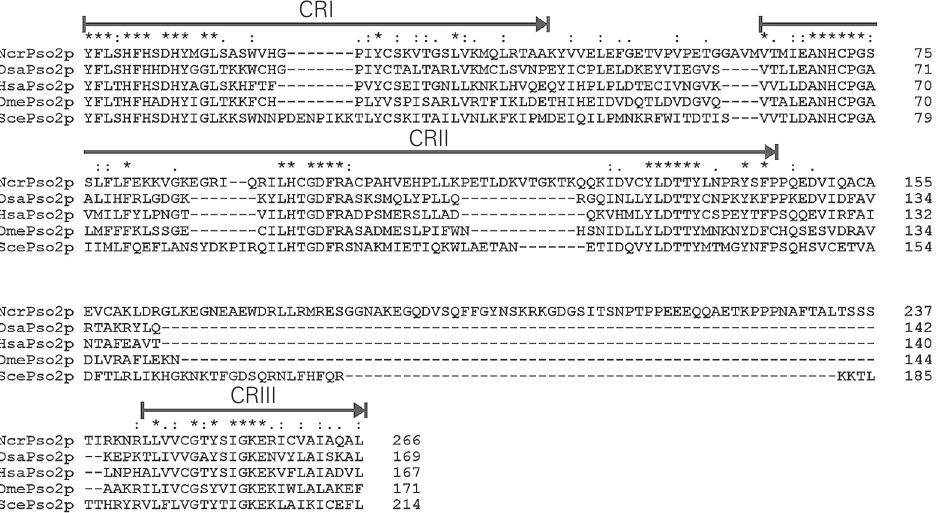
Figure 3. Multiple alignment of Pso2p conserved region sequences (CRI to CRIII) from yeast ( Saccharomyces cerevisiae , ScePso2p), humans ( Homo sapiens , HsaPso2p), filamentous fungi ( Neurospora crassa , NcrPso2p), fruit flies ( Drosophila melanogaster , DmePso2p), and rice ( Oriza sativa , OsaPso2p). Identical amino acid residues are indicated by an asterisk and amino acid residues with similar physico-chemical characteristics by one or two dots in CRs. The positions of the CRs are indicated by